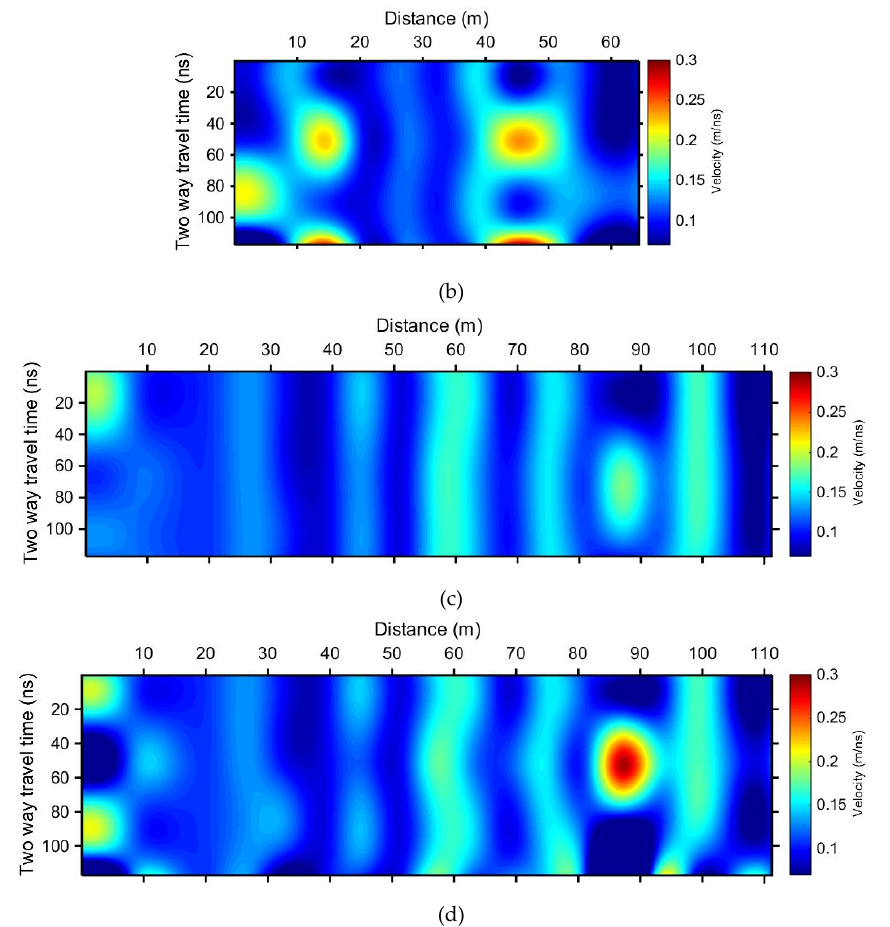
Figure 8. GPR velocities. ( a ) The time migration velocity of the section depicted in Figure 7b. ( b ) The interval velocity attribute based on ( a ). ( c ) The time migration velocity of the section depicted in Figure 7d. ( d ) The interval velocity attribute based on ( c ).